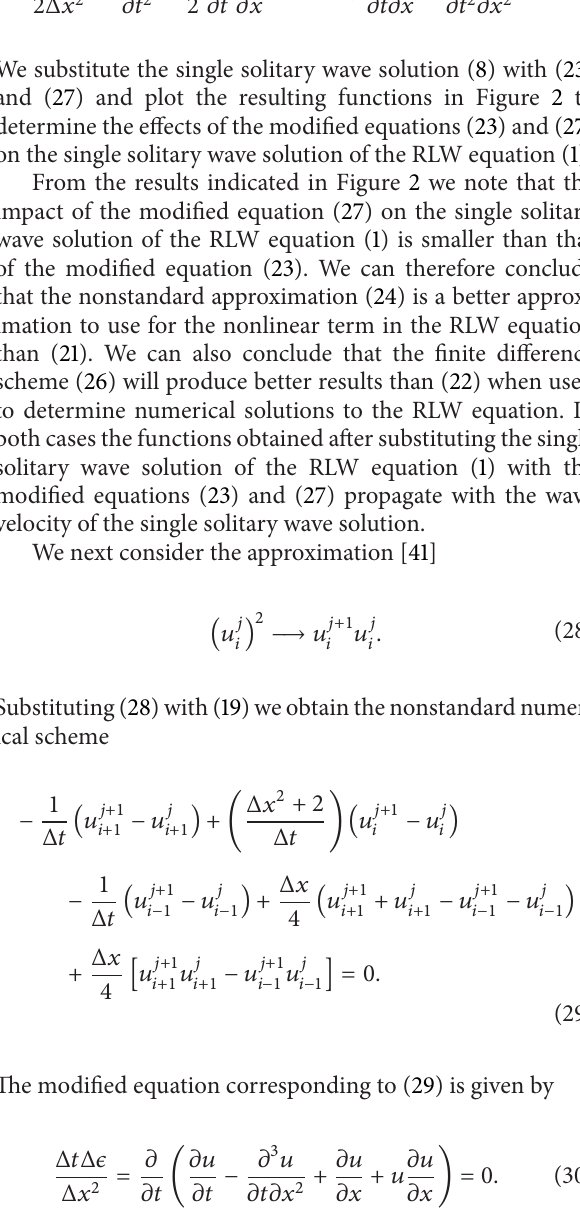
Figure 1: Plot comparing the modified equations obtained for explicit (18) (− − −) and implicit (20) (solid line) approximations to the derivative 𝜕𝑢/𝜕𝑥 after substituting the single solitary wave solution to the RLW equation (8) with (18) and (20) taking V = 0.1 and 𝑥 0 = 0 .